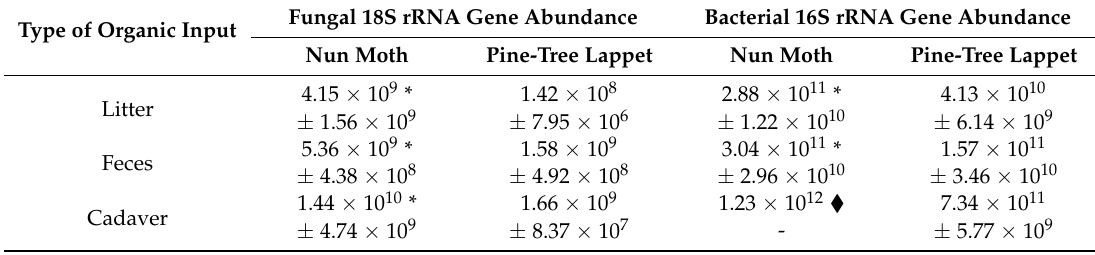
Table 2. The mean ± standard error of the fungal 18S rRNA and the bacterial 16S rRNA gene copy number per gram of dry material of the organic input (litter, insect feces and larval cadavers) of the nun moth ( Lymantria monacha L.) and pine tree lappet ( Dendrolimus pini L.) infested Scots pine ( Pinus sylvestris L.) forest